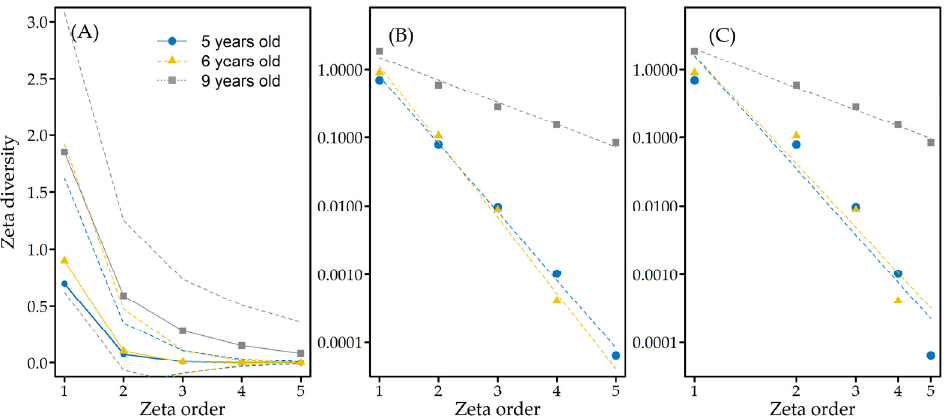
Figure 4. Zeta diversity results with ( A ) number of distinct species (zeta diversity) shared by one to five sections, here known as the zeta order; and the distribution model fitness of ( B ) exponential fitting for the independent/stochastic distribution; and ( C ) power-law fitting for dependent/niche-driven distribution for each plantation. The dashed line in 4A indicated the 95% confidence interval of the zeta diversity.